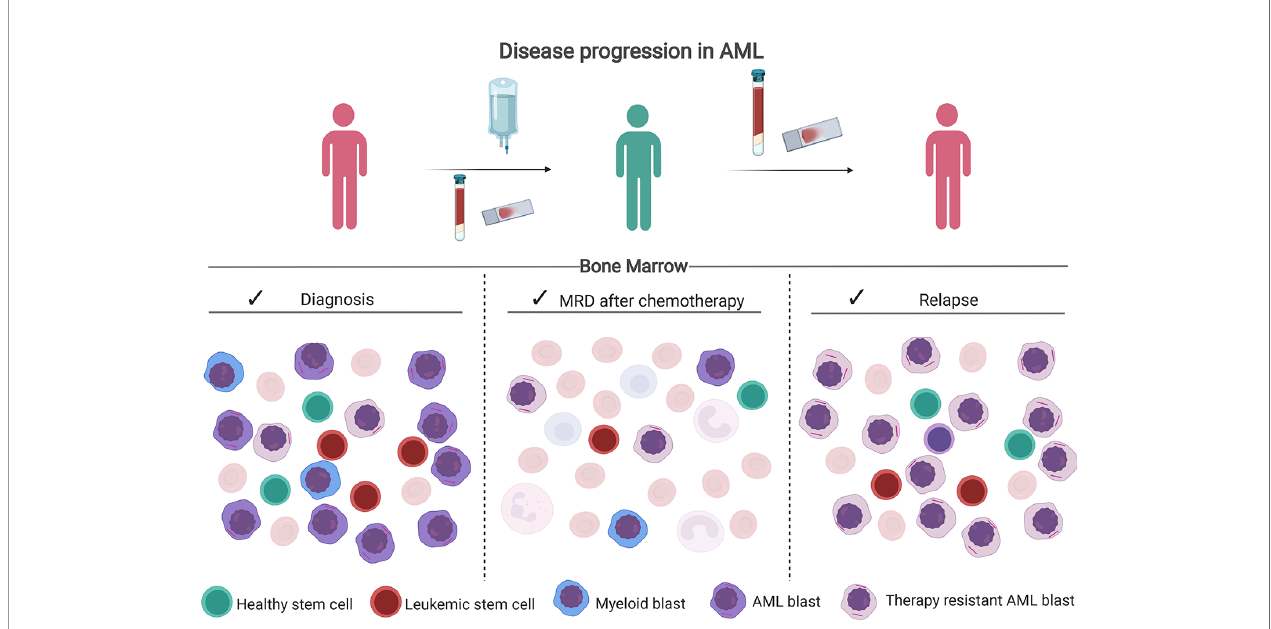
FIGURE 1 | Disease progression in AML. After therapy, chemotherapy-resistant leukemic blasts and leukemic stem cells can remain in the bone marrow. Assessment of the percentage of residual leukemia cells after chemotherapy via multiparameter fl ow cytometry (MFC) or molecular methods is called MRD. In particular, the presence of leukemia stem cells (LSC) is of prognostic relevance as they are presumed to initiate the relapse. Created with